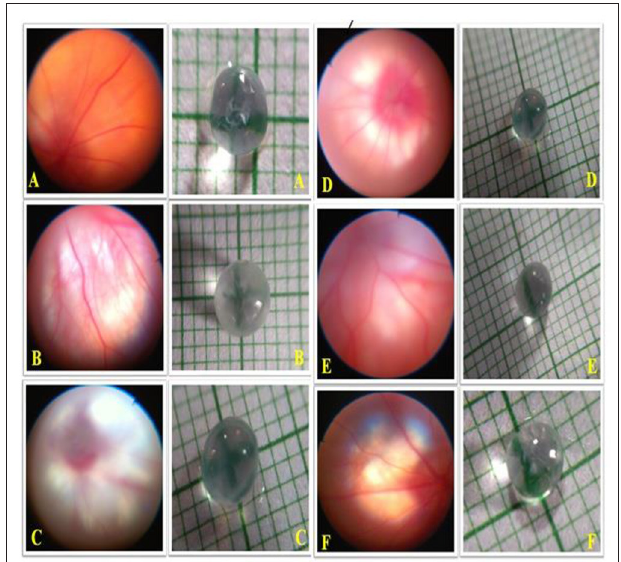
FIGURE 8 | Effects of OMT on the retinal structure and visual field. Normal group: (A) normal retinal vasculature along with normal visual field as indicated by lens opacity; (B) glaucoma control group: evident retinal fibrosis along with bilateral opacity in the lens upon DEX exposure; (C) standard group: restoration of retinal vasculature, however, without efficient detangling of the blood vessels and reduction in opacity as compared to the control group; (D) treatment 1 group: retinal fibrosis still evident with opacity in the lens; (E) treatment 2 group: significant restoration of retinal vasculature along with betterment in the visual field as indicated by the decline in lens opacity; (F) treatment 3 group: proper restoration of the retinal vasculature along with optimum lens clarity. Normal: 100 µ l of distilled water; control: 0.1ml of 0.1% DEX solution; treatment 1: 50 µ l of 0.25% OMT solution; treatment 2: 50 µ l of 0.5% OMT solution; treatment 3: 50 µ l of 1% OMT solution; standard: 100 µ l of 1% of dorzolamide